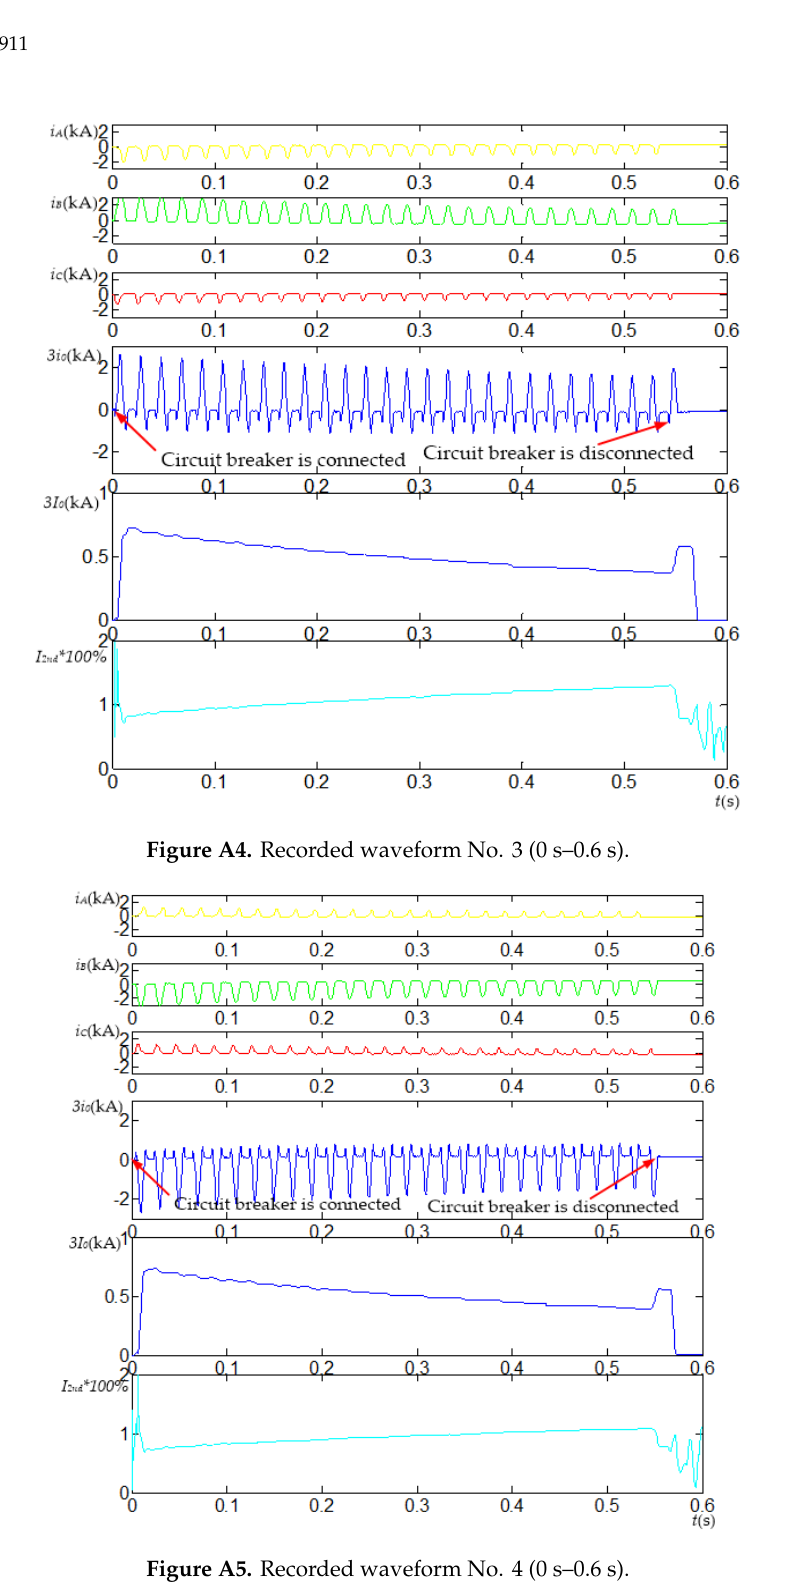
Figure A3. Recorded waveform No. 2 (0 s – 0.6 s).